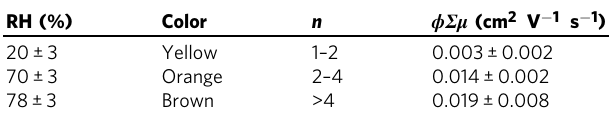
Table 1 Average ϕΣμ values measured by fp-TRMC at 450